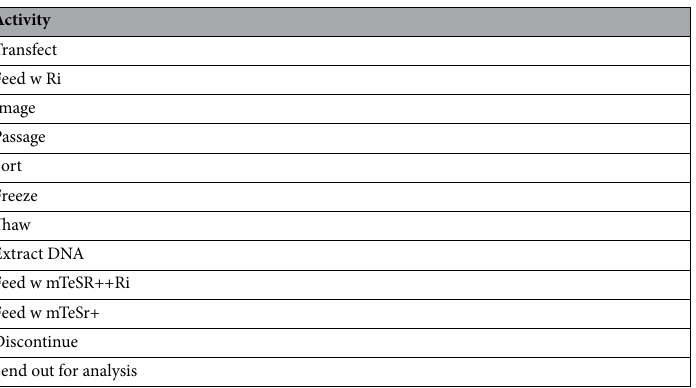
Table 3. The activities that can be selected for any cell sample on any day from the drop-down list in the Activity column in the Calendar